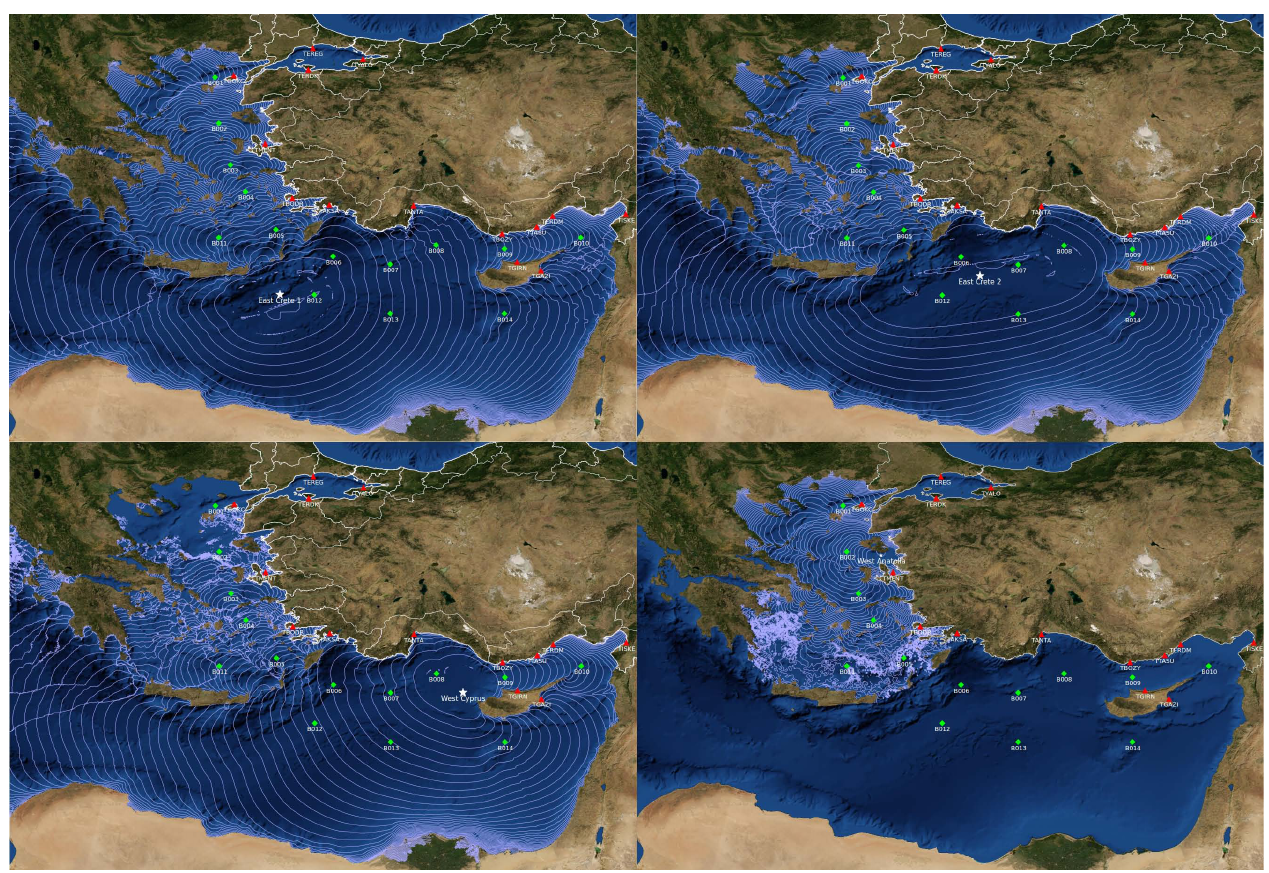
Fig. 13. Virtual scenarios with tsunami wave propagation generated by earthquake events (and with virtual sensor environment) selected in 2011 for testing, demonstration and validation of Turkish system as well as used for training: East Crete 1, top-left) based on historic event in 1303, 27.1 ◦ E, 34.5 ◦ N, M w = 8.0; East Crete 2 top right) fictitious event, 29.0 ◦ E, 35.0 ◦ N, M w = 8.5; West Cyprus, bottom left) fictitious event 31.9 ◦ E, 35.3 ◦ N, M w = 7.3; West Anatolia, bottom right) fictitious event, 26.4 ◦ E, 38.9 ◦ N, M w = 6.5.